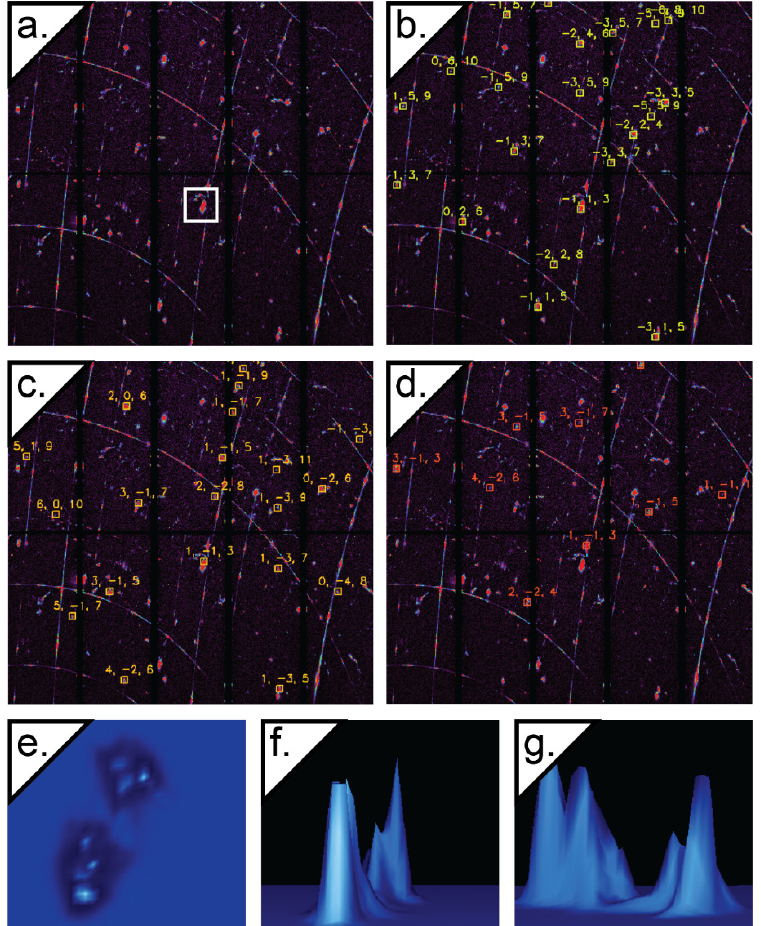
Figure 7. ( a ). This is a representative pattern taken in the region of exposed Si inclusion. ( b )., ( c )., and ( d ). show indexation fits for three different Si orientations (~33.5, 15.5, and 24.8° c -axis orientation with respect to sample normal, respectively). ( e ). This is a magnified view of the {113} reflection outlined by a white box in ( a,f ). and ( g ). show three-dimensional (3D) projections of the peaks from e. in vertical, and horizontal transects, respectively.